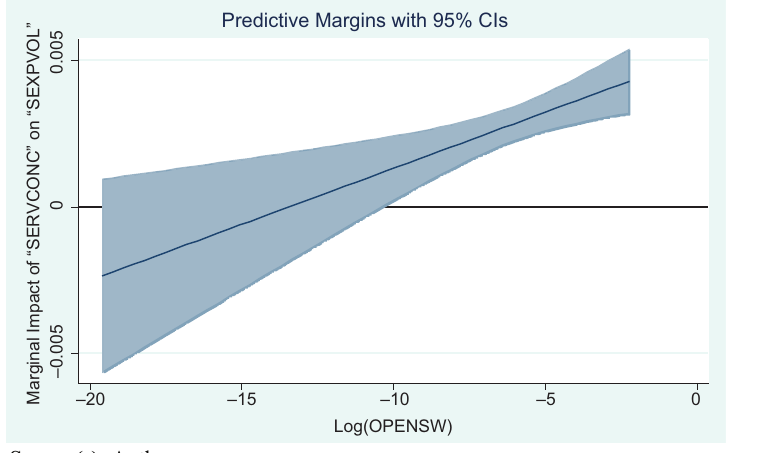
Figure 2. Marginal impact of “ SERVCONC ” on “ SEXPVOL ” , for varying values of “ OPENSW ”